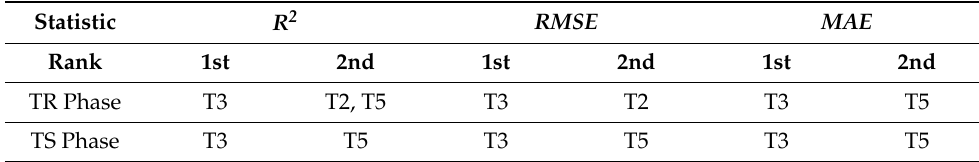
Table 6. Ranking of models based on R 2 and RMSE